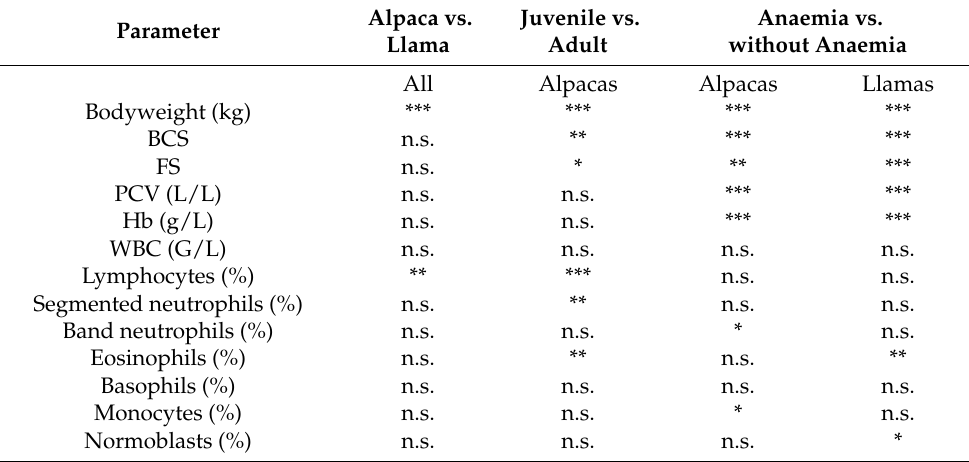
Table 1. Results of the Wilcoxon test to check for differences in species (alpacas vs. llamas), gender (male vs. female), age (juvenile vs. adult), and presence of anaemia (anaemia vs. without anaemia). No data on the influence of age are available for llamas, since the juvenile llamas group contained only two animals. There were no significant differences between male and female animals for any of the parameters. * = p < 0.05; ** = p < 0.01; *** = p < 0.001; n.s. = not significant. Alpaca vs. Juvenile vs. Anaemia vs. Parameter Llama Adult